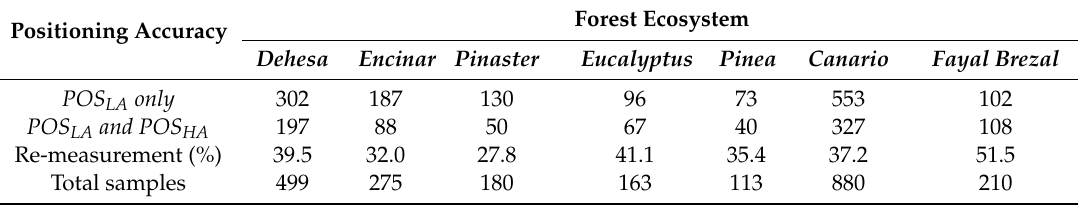
Table 2. Proportion of the sampling dataset measured both in the 3rd and 4th campaigns of the National Forest Inventory (NFI) using traditional plot positioning methods in the NFI ( POS LA ) when using Global Navigation Satellite System (GNSS) equipment ( POS LA